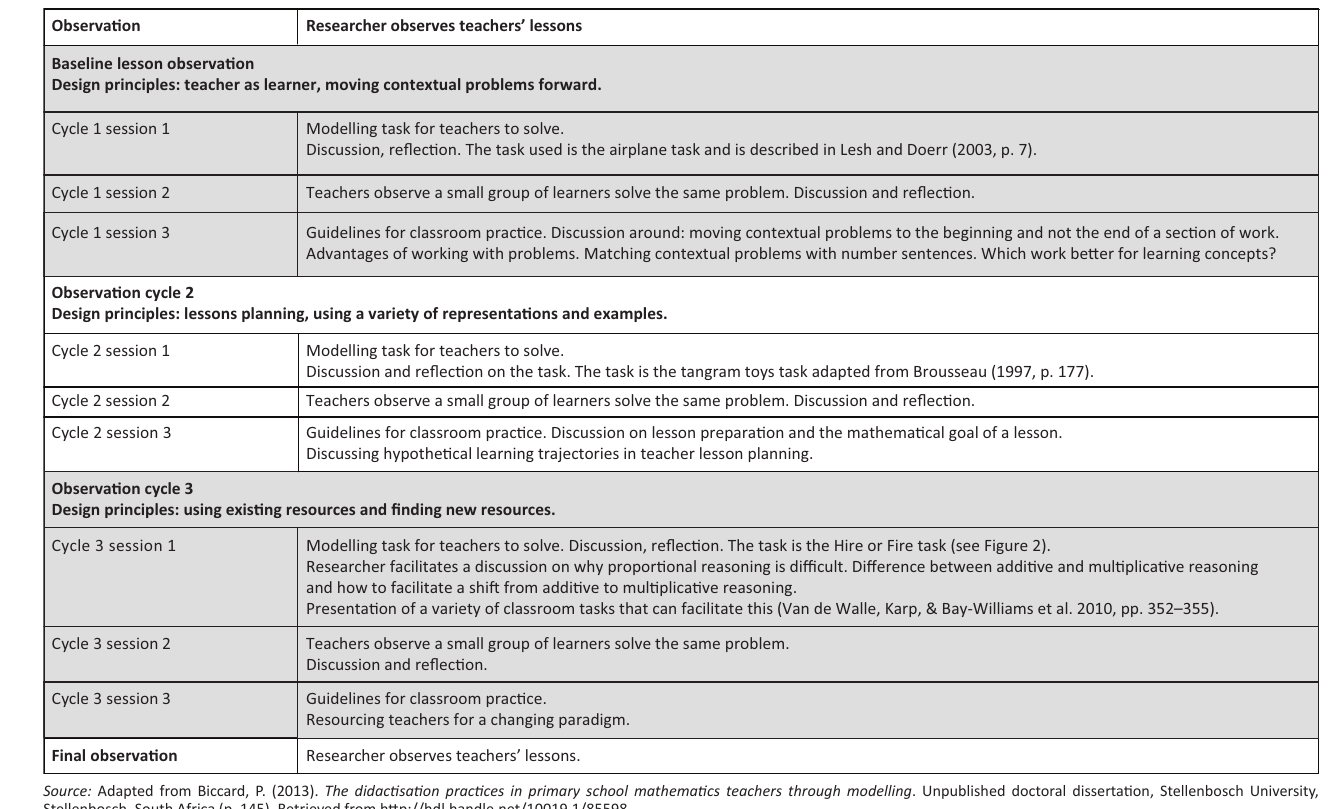
FIGURE 3: Design-based research